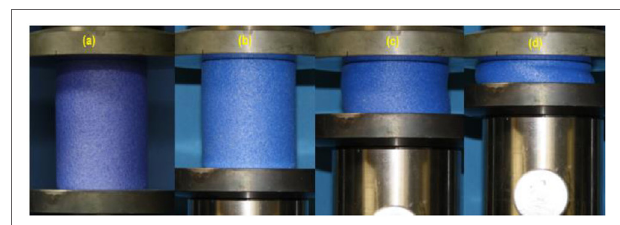
FigUre 4 | The progressive compression process of the foam filler.